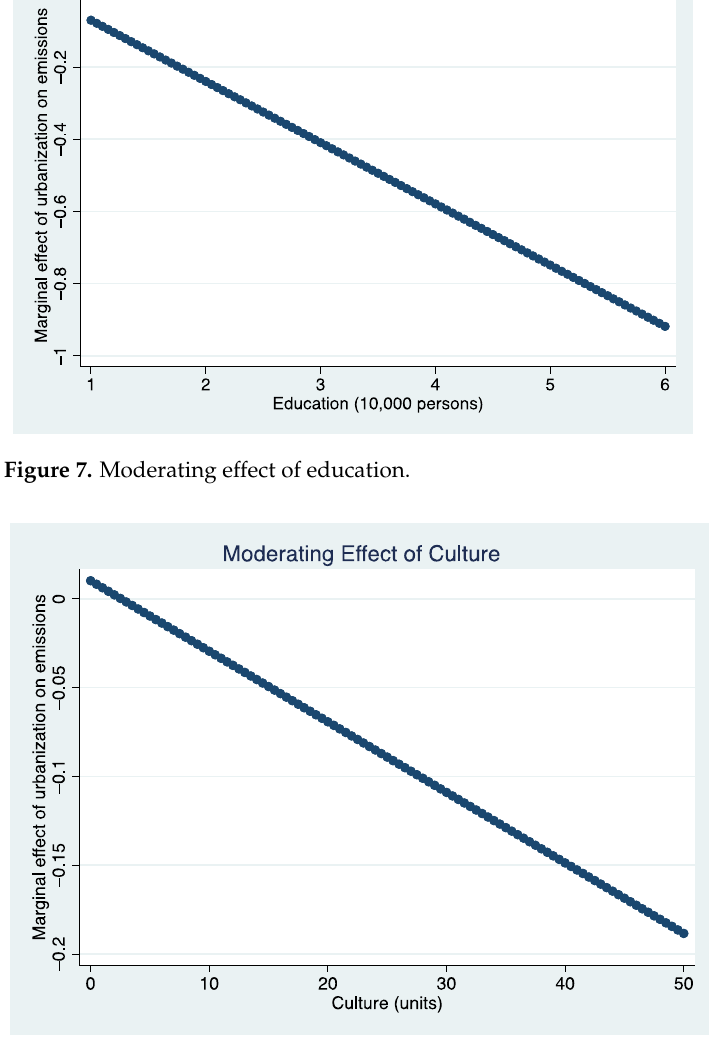
Figure 8. Moderating effect of culture.